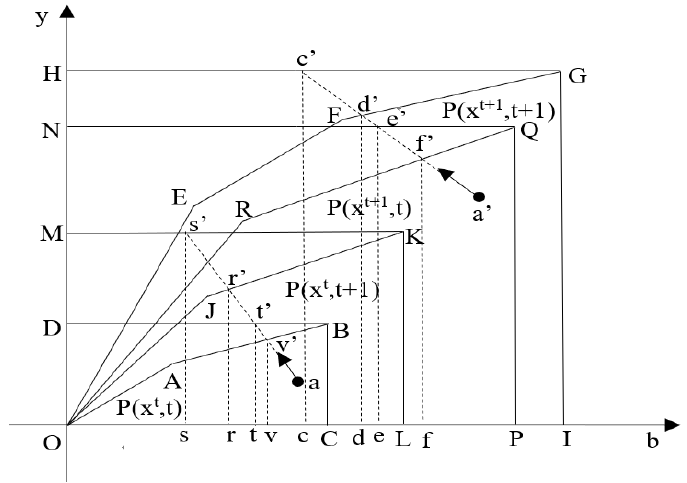
Figure 3. Decomposition of the change of opportunity cost.